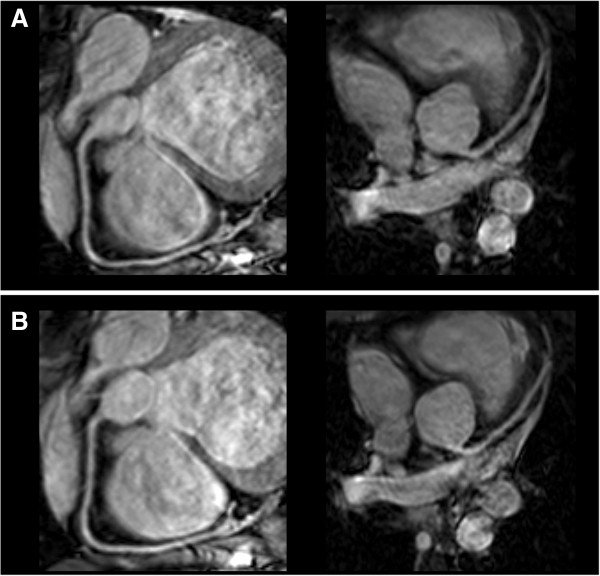
Double oblique single-breathhold 3D bSSFP coronary magnetic resonance angiograms of the right coronary artery and left anterior descending in two healthy volunteers obtained during two separate scanning sessions: reference (A), repeat (B). Images were multi-planar reformatted.